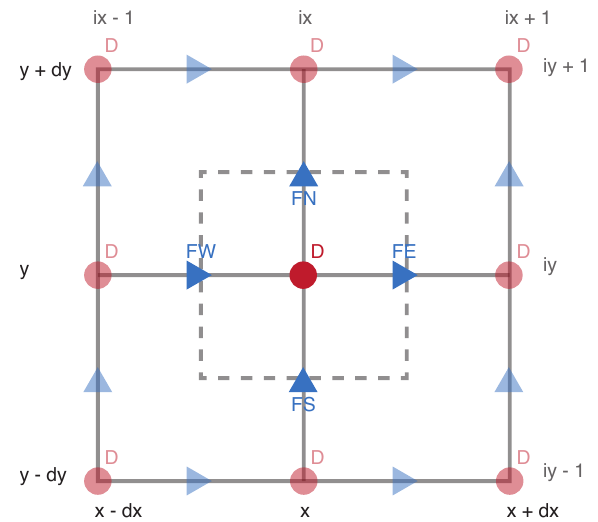
Figure 1. Schematic representation of the model grid. Ice thickness h , bedrock elevation b and diffusivity D are calculated on regular grid points (ix, iy). Halfway between these points, the lateral flux (FN, FS, FW, FE) of ice is calculated on staggered grid